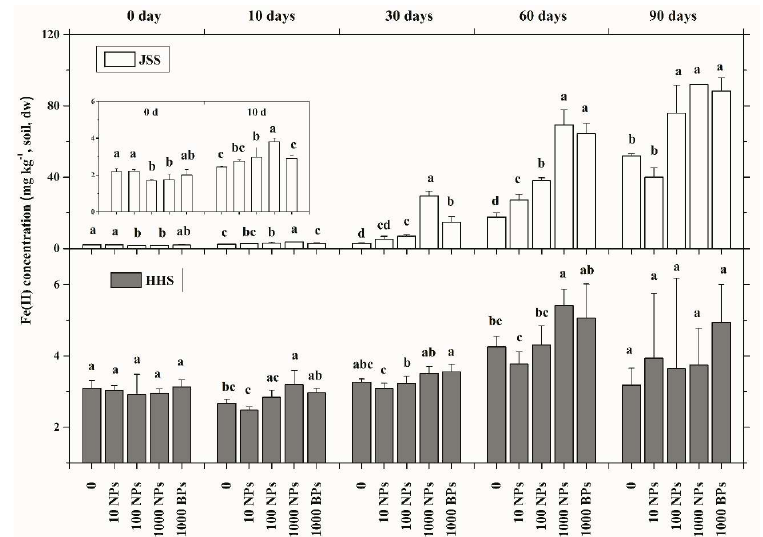
Figure 6. The Fe(II) of two tested soils during flooding–drying period. White: Jinshan Soil (JSS); Gray: Heihe Soil (HHS). Error bars indicate the standard deviation of the mean ( n = 3). Lowercase letters indicate the significance between the different dose exposure treatments over the same period.